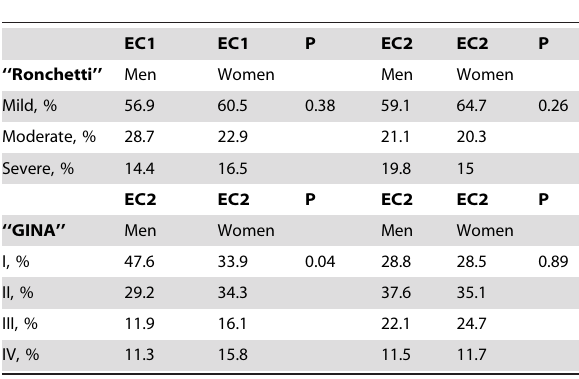
Table 2. Cross-sectional distribution of asthma severity in subjects with data available at both